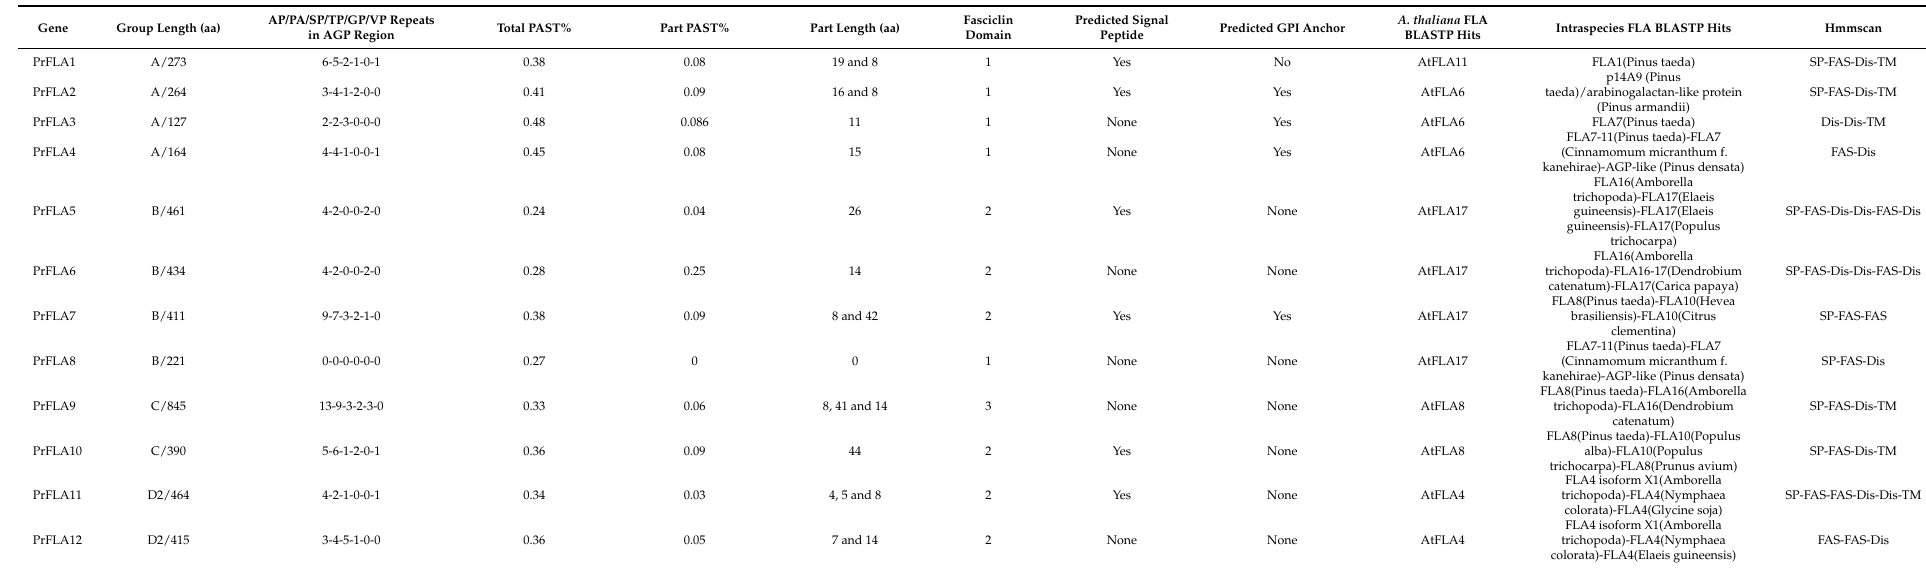
Table 1. Classification group according to phylogeny and other features of